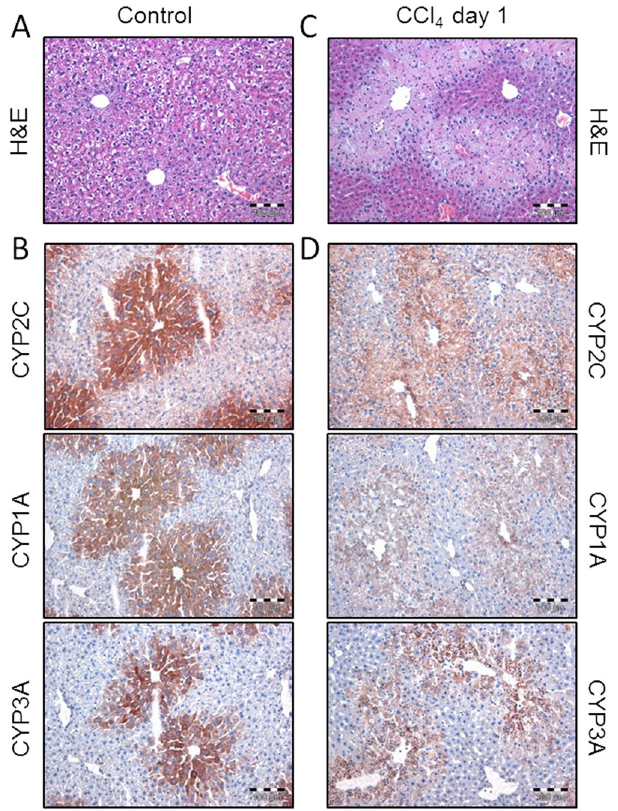
Figure 3. Staining of the liver lobule before and after CCl 4 administration. ( A ) H&E staining in healthy mice. ( B ) Immunostaining of three cytochrome P450 enzymes (CYP1A, CYP3A and CYP2C) in healthy mice. ( C ) H&E staining in intoxicated mice. ( D ) Immunostaining of three cytochrome P450 enzymes (CYP1A, CYP3A and CYP2C) in intoxicated